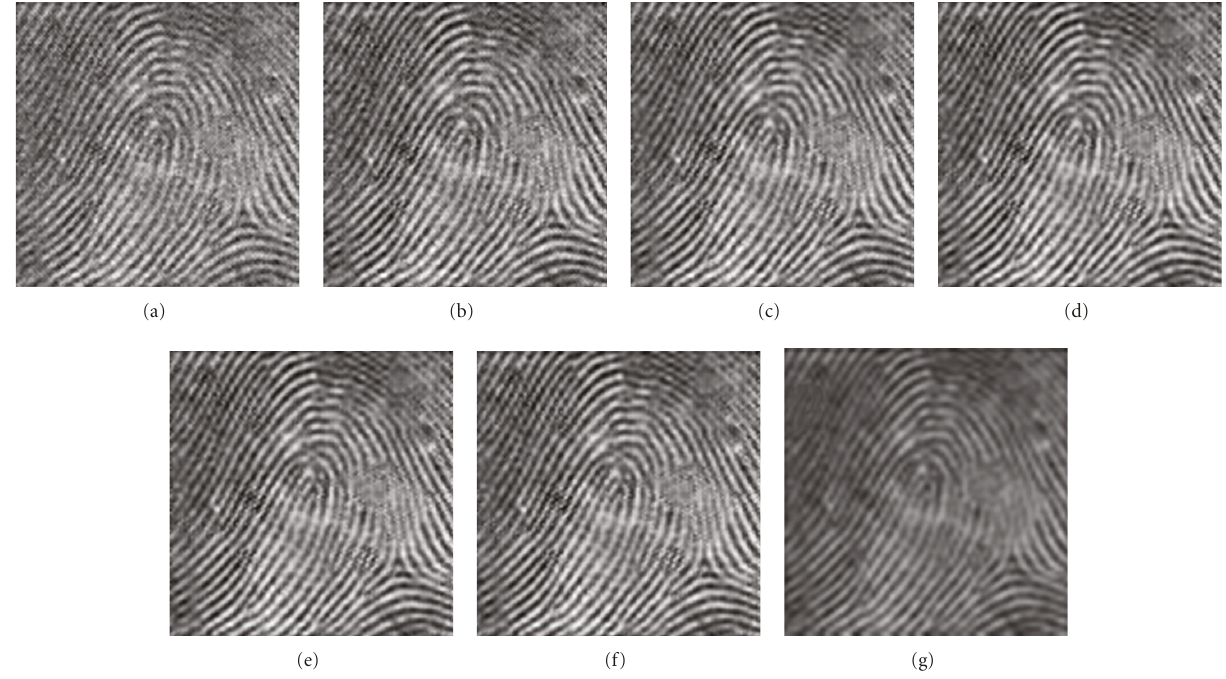
Figure 9: Recovered watermarks from Lena image after JPEG2000 compression. (a) Rate = 0 . 3 (b) Rate = 0 . 4 (c) Rate = 0 . 5 (d) Rate = 0 . 6 (e) Rate = 0 . 7 (f) Rate = 0 . 8 (g) Rate = 0 .